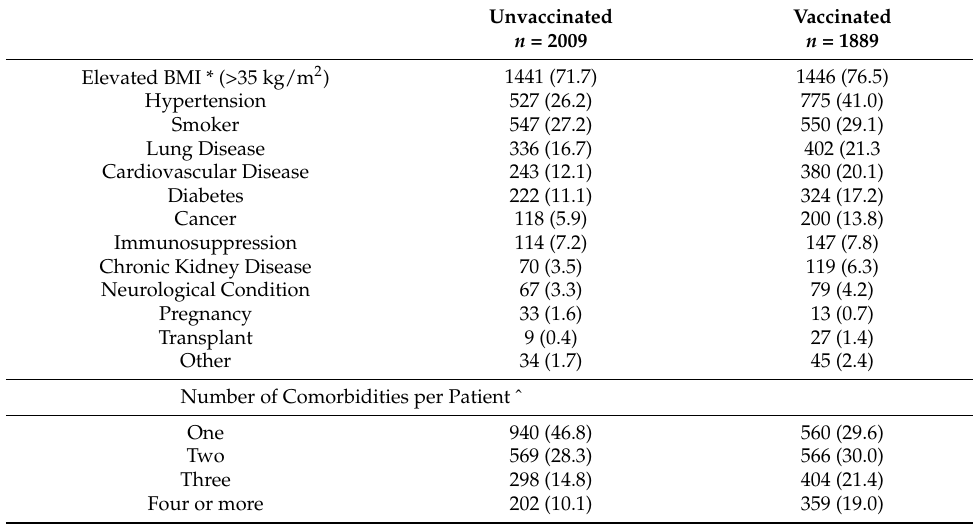
Table 2. Comorbidities, n